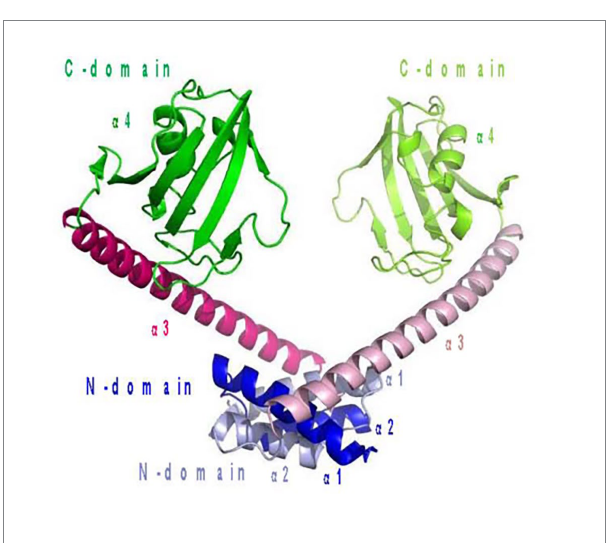
FIGURE 5 Peptidylprolyl isomerase from Shewanella sp. SIB1 structure (Budiman et al.,